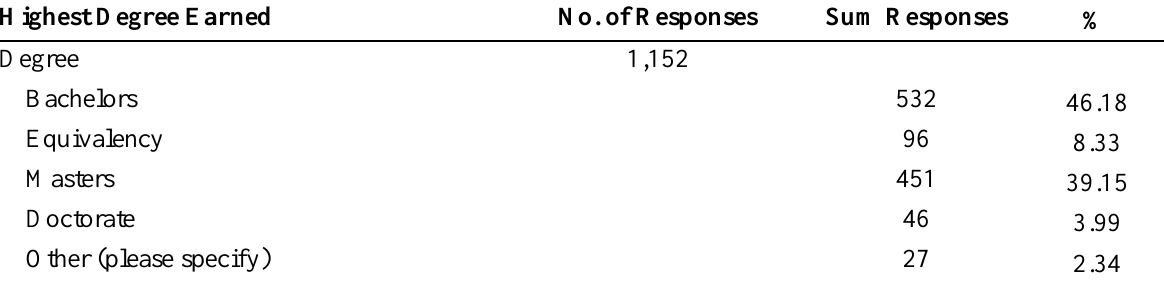
Number of Survey Respondents by Degree